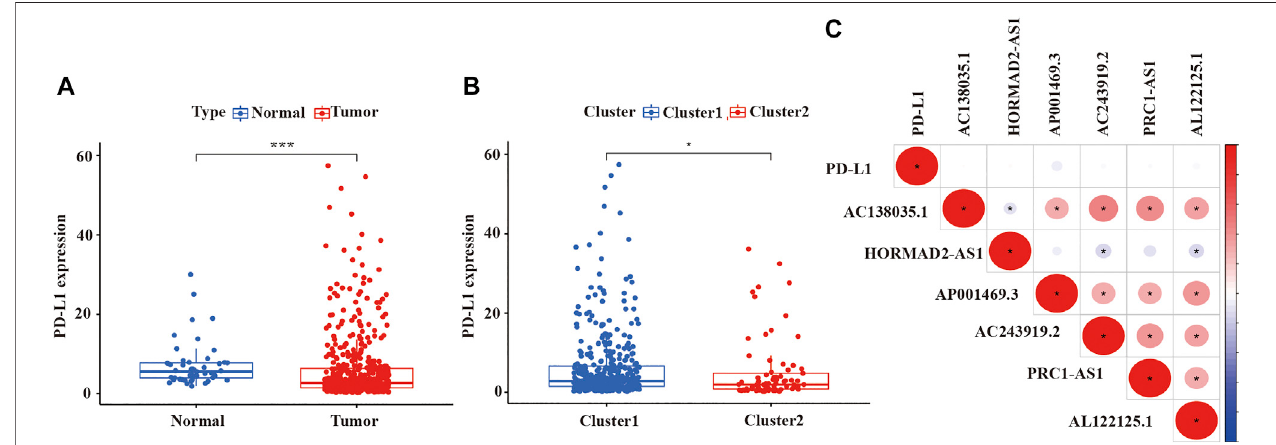
FIGURE 4 | The expression level of PDL-1 in LUSC and the relationship between PD-L1 with prognostic-related lncRNAs. (A) The expression of PDL-1 in LUSC tissue samples. (B) The expression of PDL-1 in two clusters. (C) The relationship between PDL-1 and prognostic-related lncRNAs. LUSC, lung squamous cell